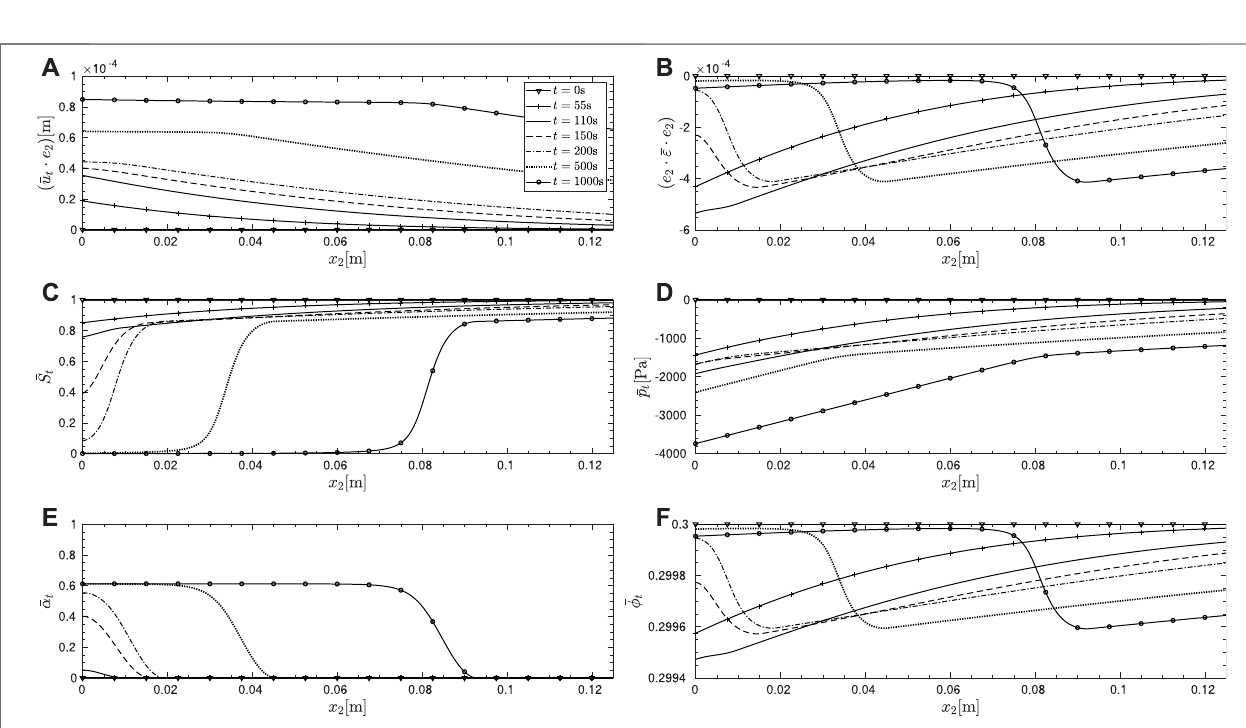
Frontiers in Mechanical Engineering |